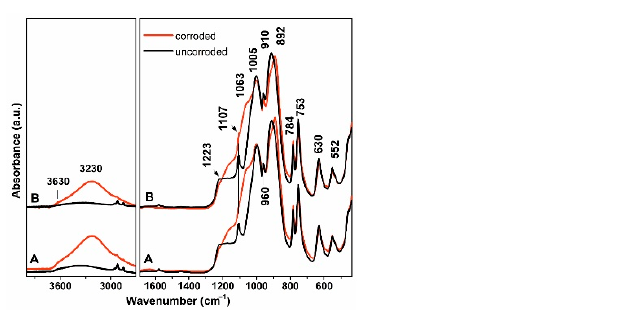
Figure 6. ATR-FTIR spectra of the studied samples prior and after corrosion process.